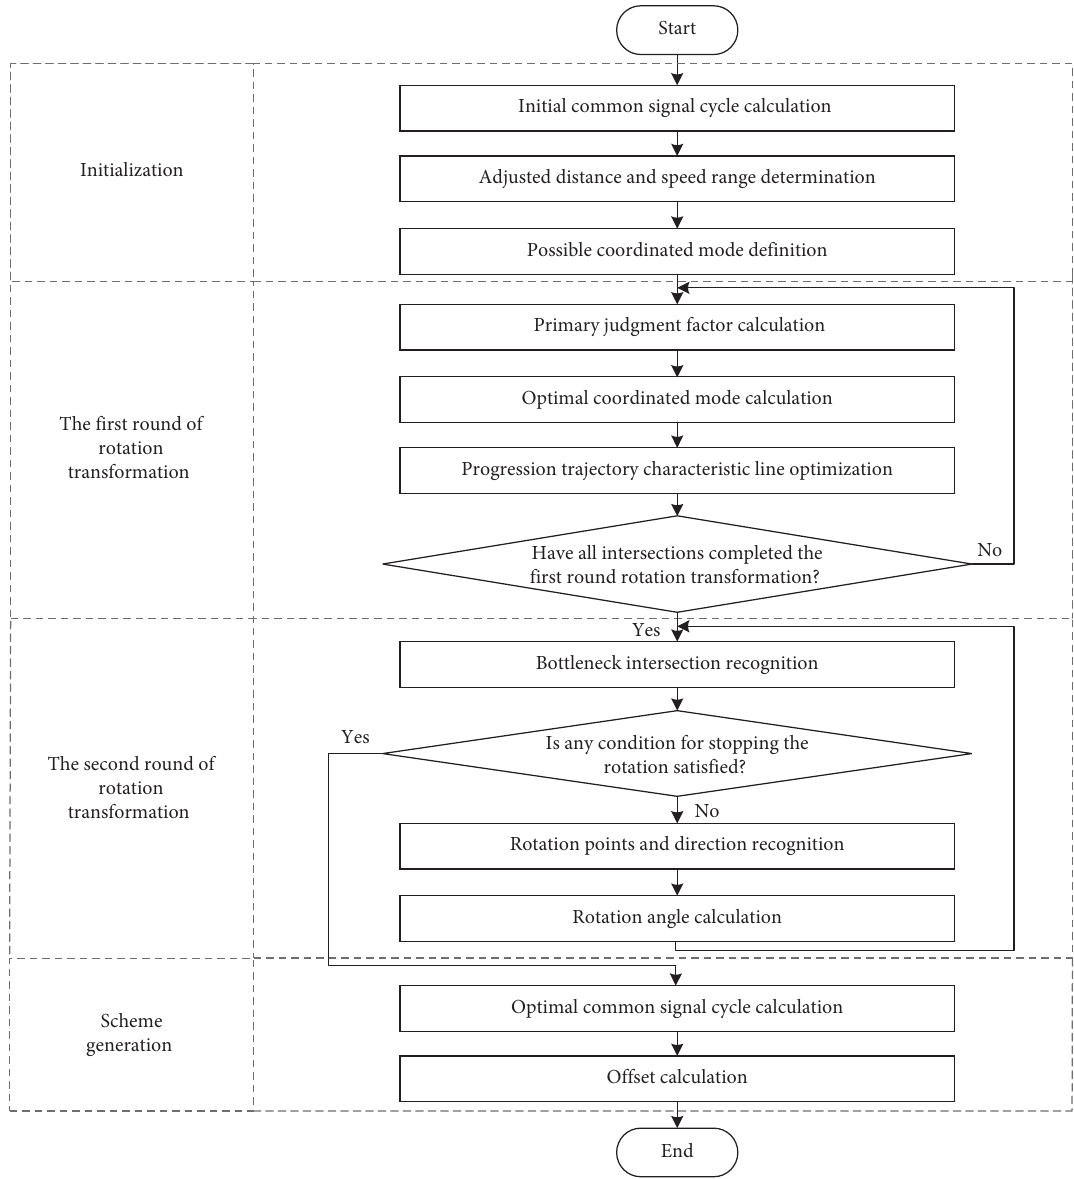
Figure 1: The design flow chart of the proposed